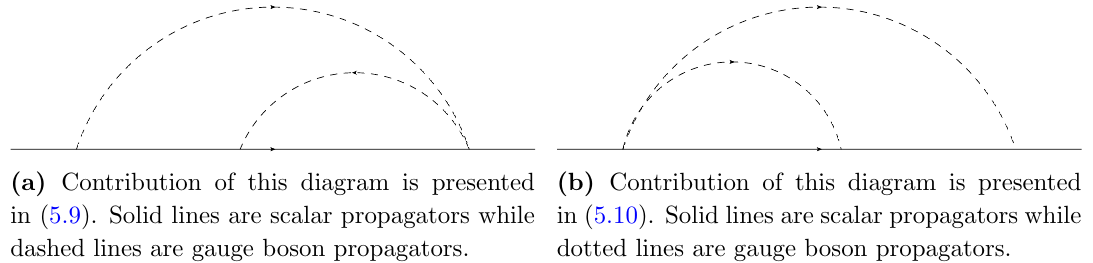
(a) Contribution of this diagram is presented in (5.9). Solid lines are scalar propagators while